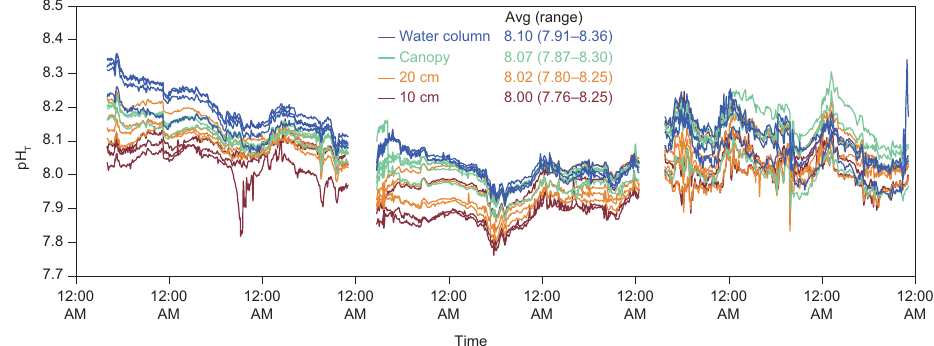
Figure 7. pH variability within 1m 3 of kelp forest in Kobbefjord, Nuuk, during three deployments in late August–September 2013. Sixteen pH sensors were configured in situ in a 3-day array with four sensors at 0.1m from the bottom, four sensors at 0.2m, four sensors just underneath the canopy and four in the water column above the canopy, which typically extended about 0.75m above the